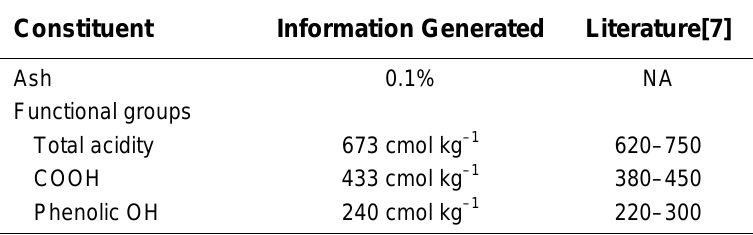
Some Functional Groups of Humic Acid Derived